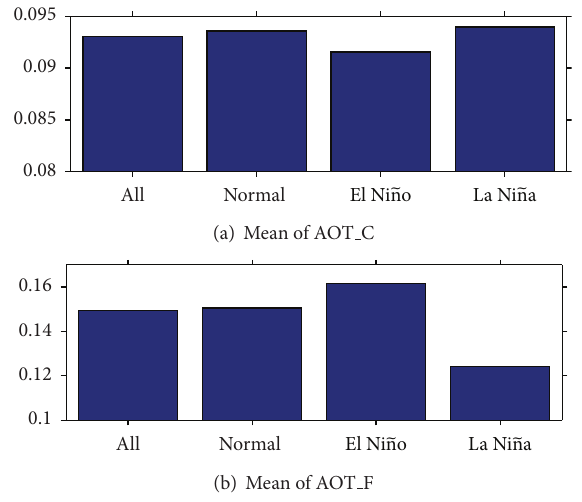
Figure 8: The average AOT over the SCS, (a) coarse mode aerosol, and (b) fine mode